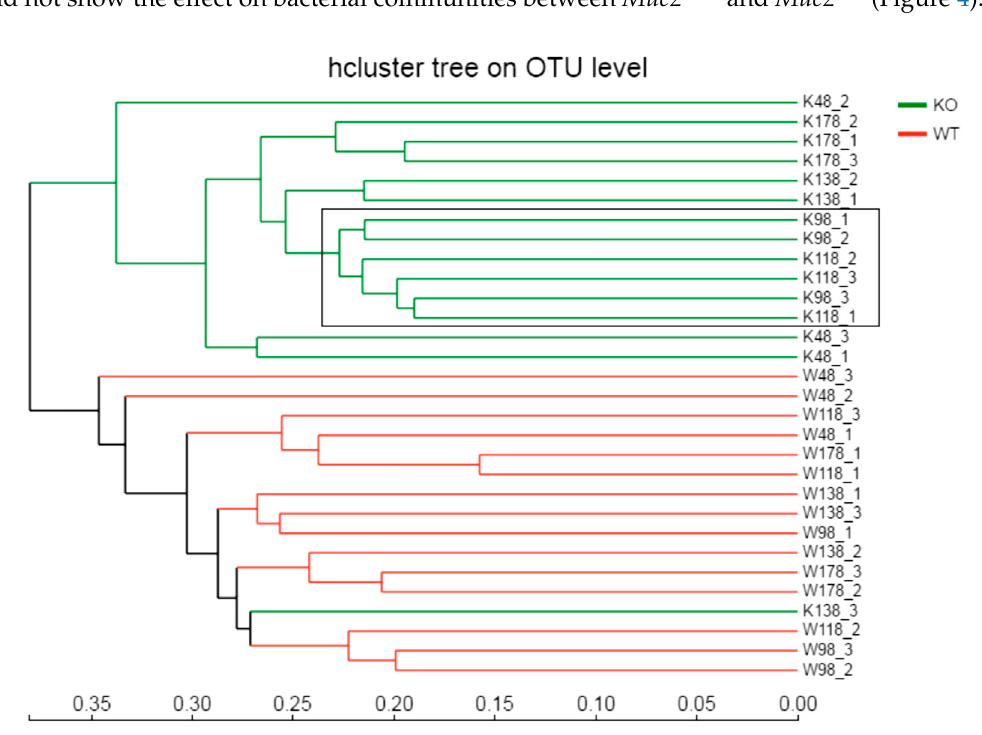
Figure 4. The hierarchical clustering was generated based on the Bray–Curtis method and the difference was significant between Muc2 − / − and Muc2 +/+ mice with 16S rRNA gene-sequencing based on OTU levels. WT/W, Muc2 +/+ mice; KO/K, Muc2 − / − mice. The sample names at the right side represented the sampling time and genotypes. For example, K48_2 indicated the second sample collected from Muc2 − / − mouse at day 48, and W48_1 indicated the first sample collected from Muc2 + / + mice at day 48. Bray–Cutis dendrograms of 16S rRNA gene-sequencing based on OTU level. The number indicated the sampling time, e.g., K48_2 indicated the second sample collected at 48th day from Muc2 − / − mice.